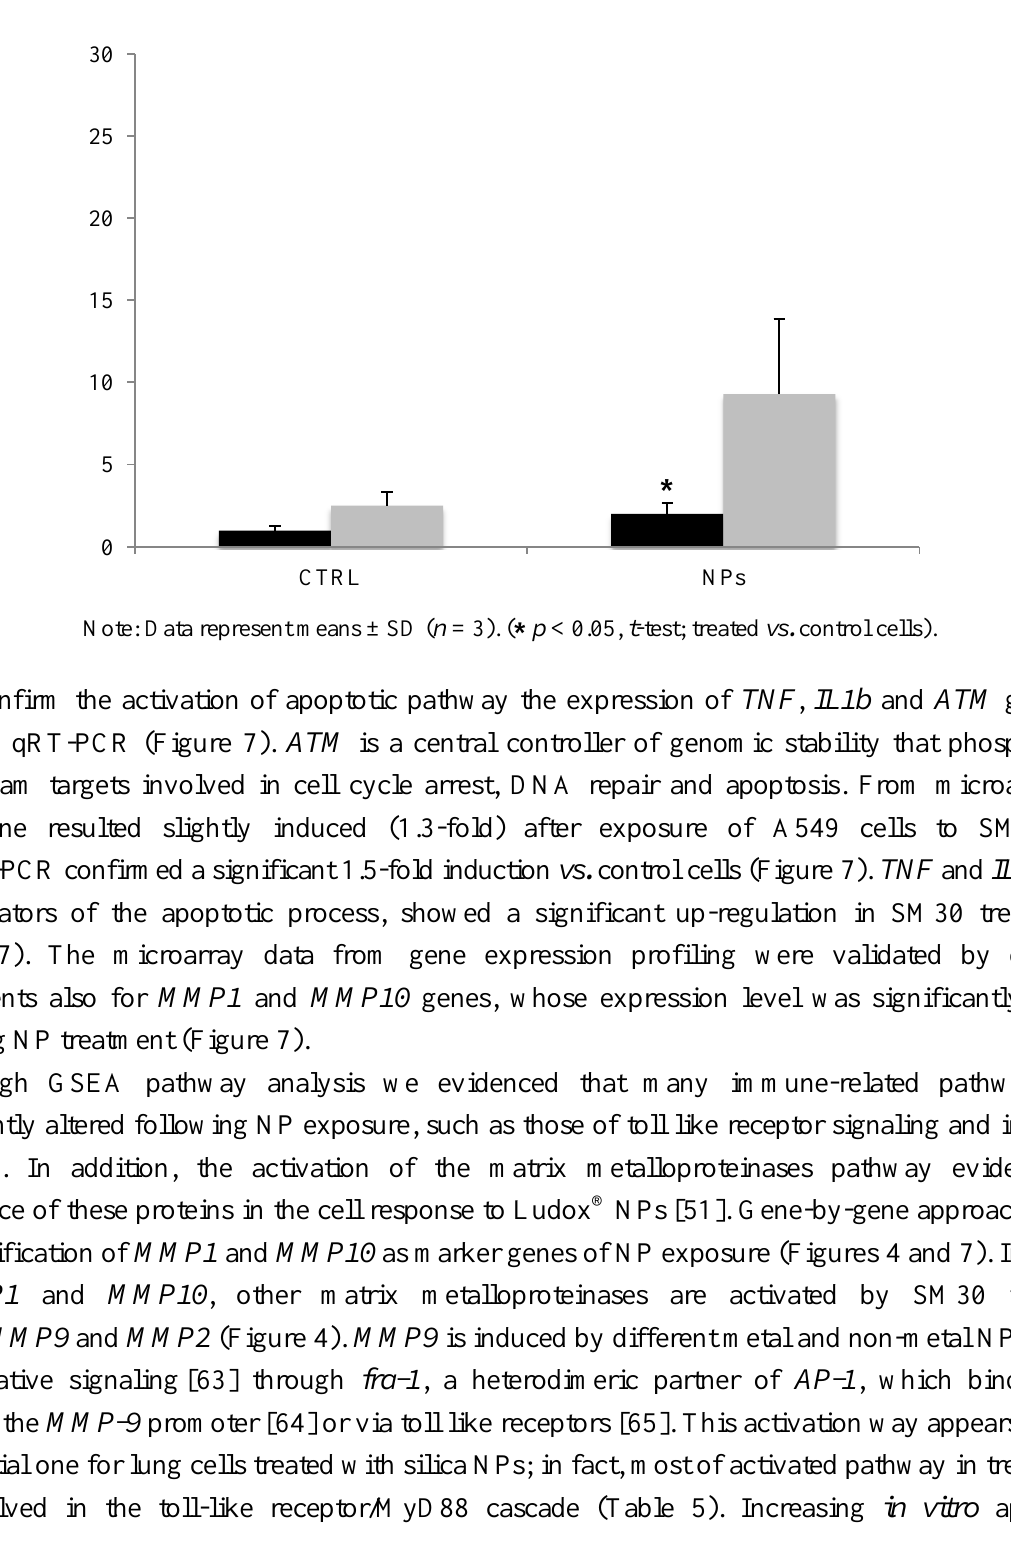
Figure 6. Apoptosis induction in cells treated with Ludox ® SM30 (0.04 mg/mL) for 2 h in serum-free medium, followed by a recovery of 3 h. After the recovery, the cells were double-stained with Annexin V-FITC/propidium iodide and analyzed by flow cytometry to detect cells in the early (black bars) or in the late stage (grey bars) of